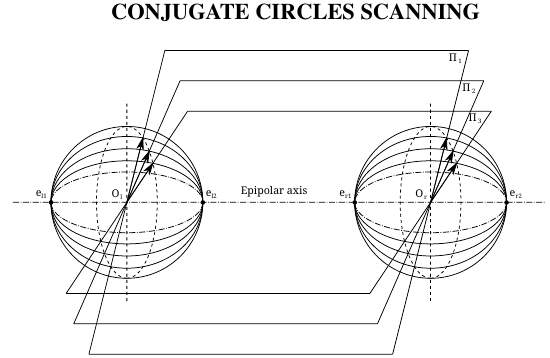
Figure 3: The intersection of the epipolar plane Π i with each unit sphere results in two epipolar circles.